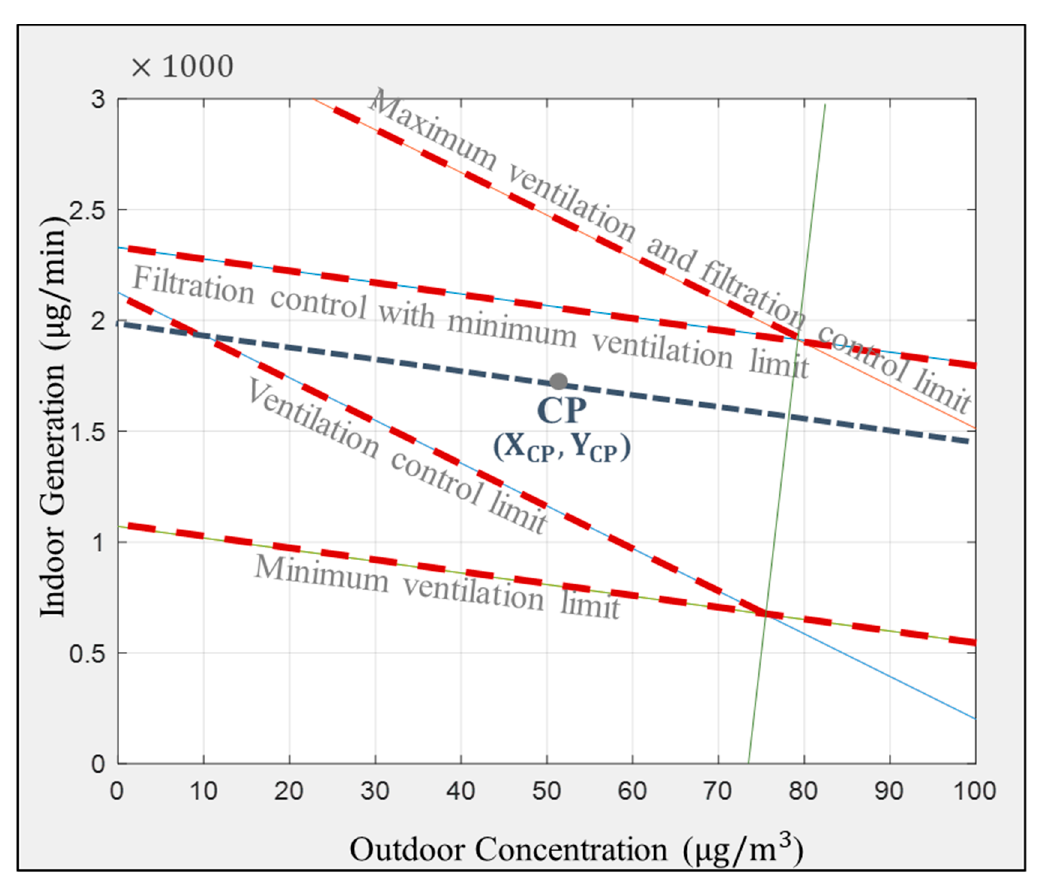
Figure 9. A linear graph passing through the CP with the same slope as the filtration + minimum ventilation control limit for estimating Q f,opt